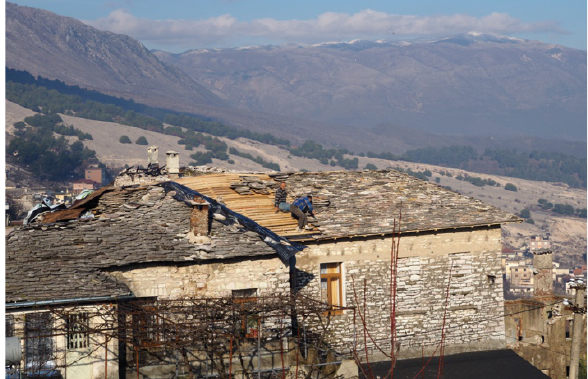
Figure 10. Traditional roof under restoration (© L.Dipasquale,